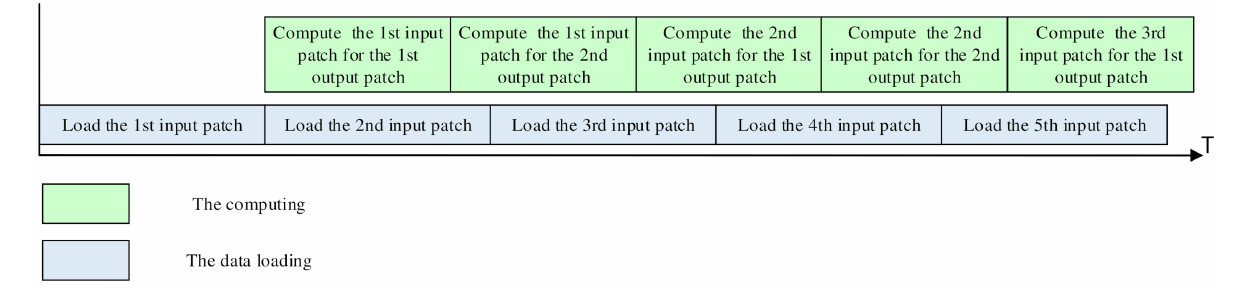
Figure 8. The parallel data loading and